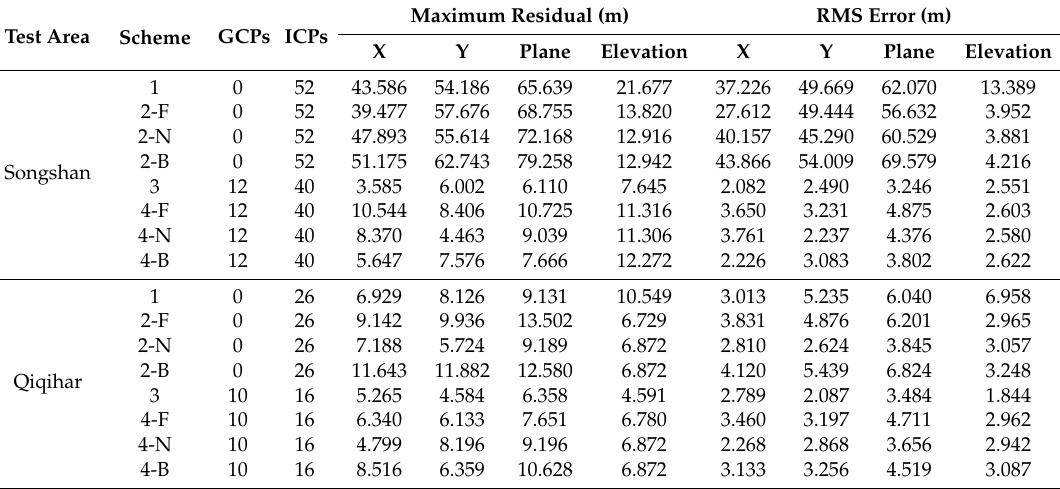
Table 2. Results of planar and stereo block adjustments.